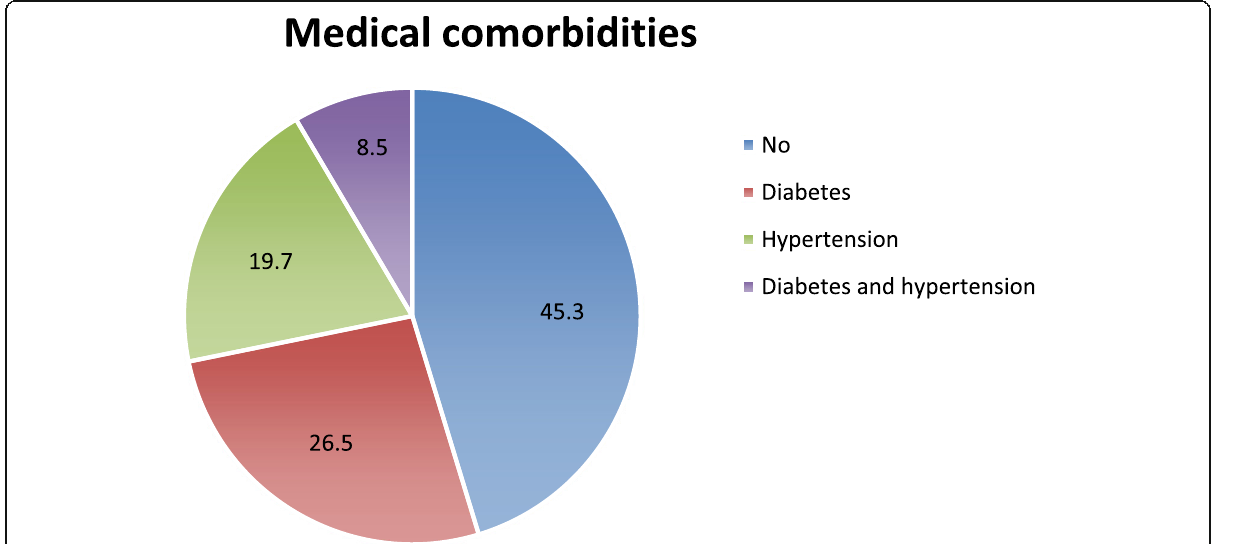
Fig. 1 Presence of medical comorbidities among the ESRD patients